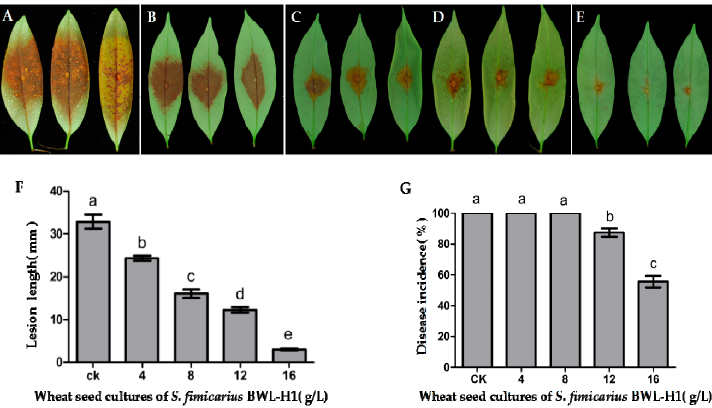
Figure 6. Antifungal activity of VOCs against P. litchii on detached leaves. ( A ) unfumigated control; ( B – E ) P. litchii inoculated leaves were fumigated with various amounts (4, 8, 12, 16 g/L) of wheat seed culture of S. fimicarius BWL-H1 volatiles; ( F , G ) Lesion length and Disease incidence were measured at 48 h post inoculation. Mean ± S.E. was based on 3 replicates. Values followed by different letters were significantly different ( p < 0.05).